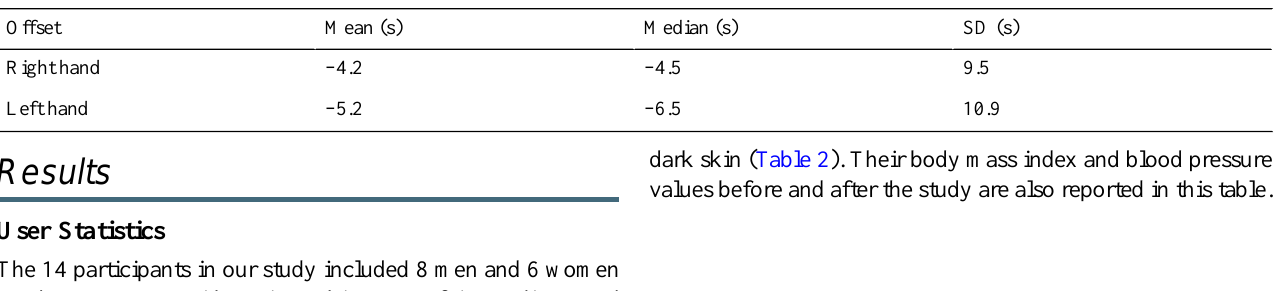
Table 1. Time offsets applied on the Withings ScanWatch for plateau matching. A negative offset indicates that Withings ScanWatch lags behind the co-oximeter.